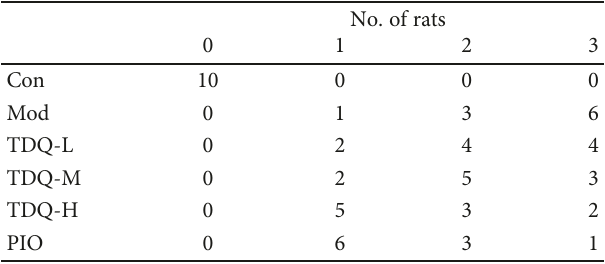
Table 1: Hepatic steatosis